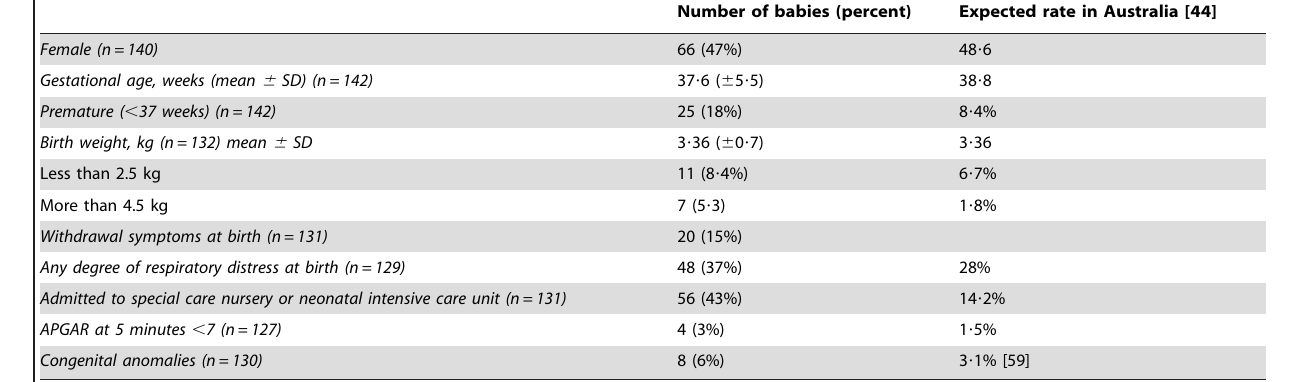
Number of babies